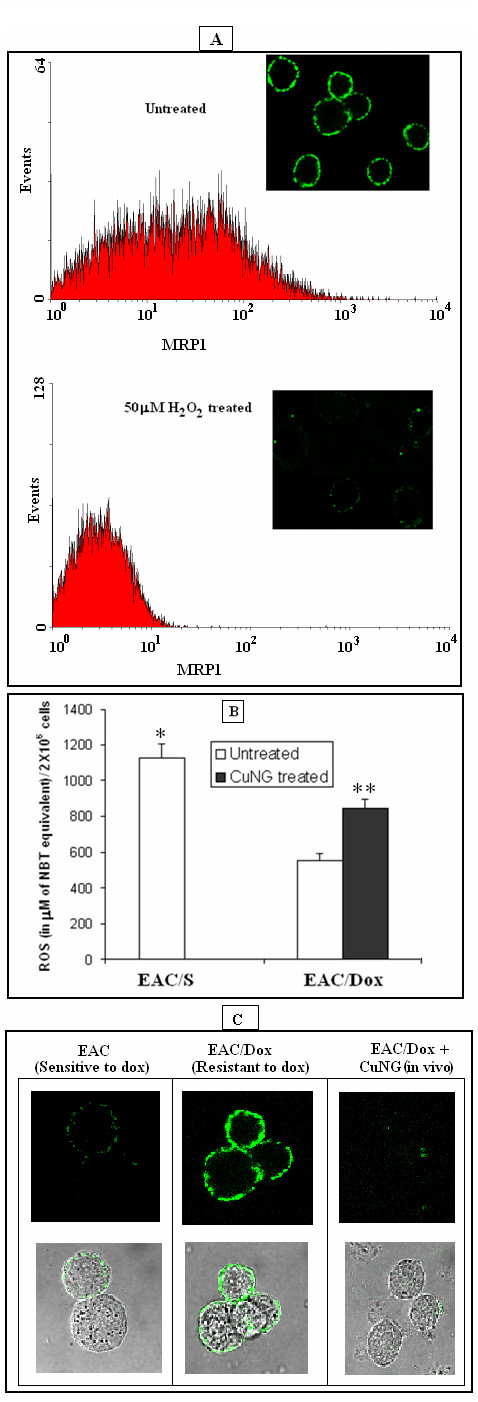
(A) Effect of exogenous H2O2 on MRP1 expression. EAC/Dox cells were incubated overnight in presence of 50 μM H2O2. Surface MRP1 expression was studied by flow cytometry and confocal microscopy. Representative data of 5 independent experiments is presented. (B) ROS generation by EAC/Dox cells ex vivo 24 h following in vivo CuNG treatment. CuNG treatment given after 7 days following inoculation with EAC/Dox cells. Results are compared with ex vivo ROS generation by EAC cells derived from EAC/S and EAC/Dox bearing mice. EAC/Dox cells following in vivo CuNG treatment and EAC/S cells generated significantly higher levels of ROS compared to EAC/Dox cells from untreated animals (*, P < 0.001 and **, P < 0.005). Results are presented as mean ± S.D. of 3 independent experiments. Each experiment was done with 5 animals in each experimental group. (C) Confocal microscopy of the effect of CuNG on MRP1 expression in EAC/Dox cells. EAC/Dox cells expressed higher levels of MRP1 than EAC/S cells and CuNG treatment reduced MRP1 expression. Results presented are representative of 3 independent experiments.